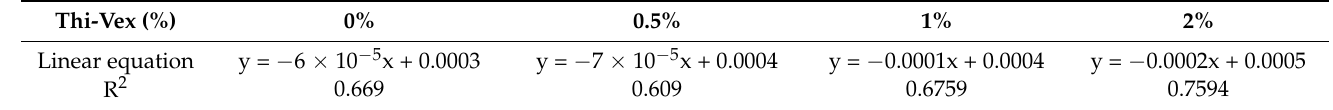
Table A3. Equations and R 2 values for individual trendlines in Figure 1c.